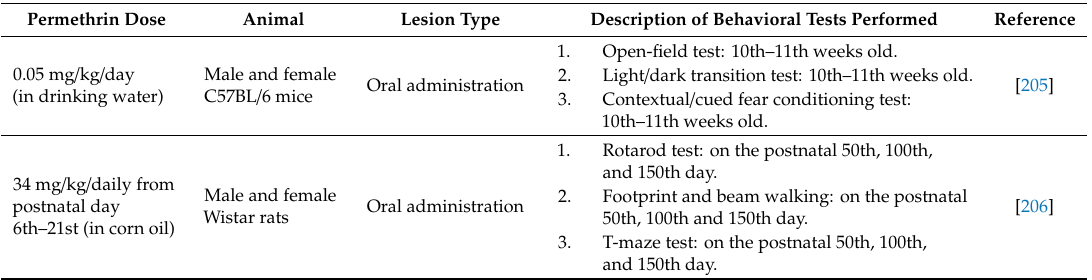
Table 7. Dose, lesion type, and behavioral evaluating methods in each permethrin-induced PD animal